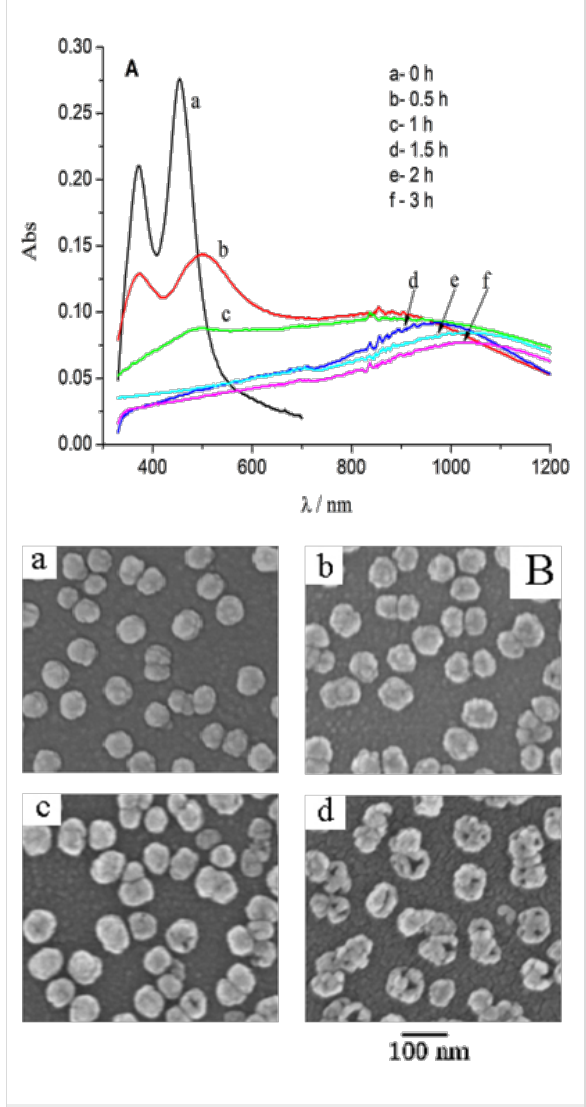
Figure 2: UV–vis–NIR absorbance spectra of ITO-supported AgNPs before and after reactions with 0.1 mM HAuCl 4 solution for various times (A). SEM images of the AgNPs after reactions with 0.1 mM HAuCl 4 solution for various times: a: 0 h, b: 0.5 h, c: 1 h, d: 2 h (B).